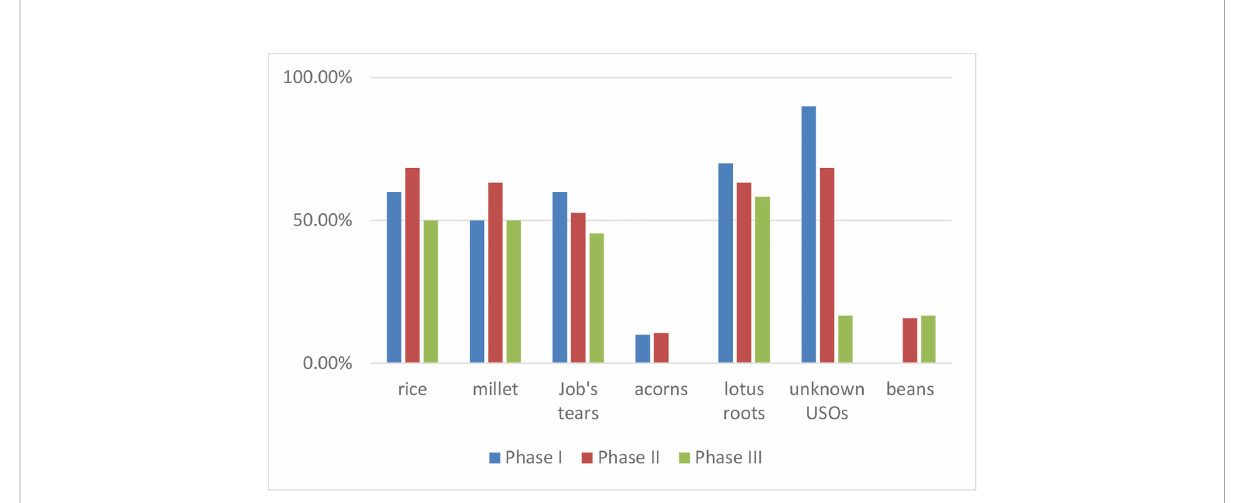
FIGURE 7 Ubiquities of different types of starch grains on Qujialing pottery vessels attributing to the different occupation